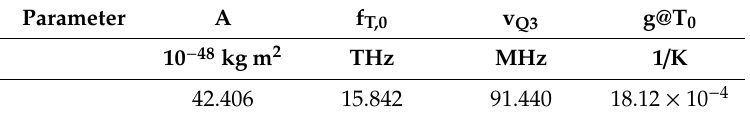
Table 5. Spin-spin relaxation time constants T 2 of transitions from Table 1 at 310 K.